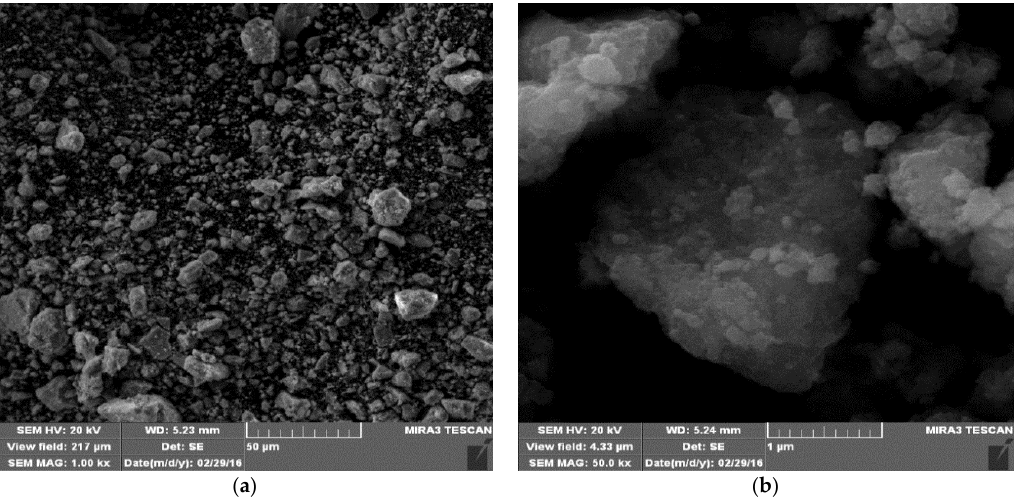
Figure 5. SEM micrographs of extracted suspended particles under different magnifications: ( a ) 1000×; ( b ) 50 000×.